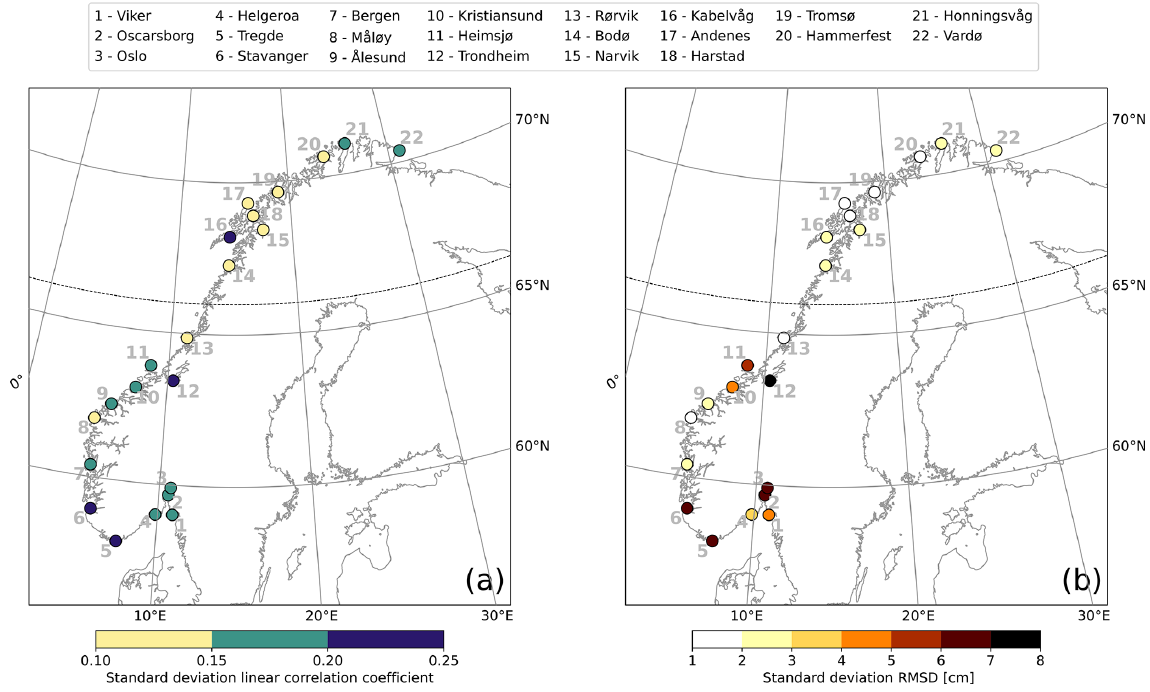
Figure 6. Comparison between coastal sea-level signals from in situ measurements and area-averaged remote sensing data. At each tide-gauge location, the standard deviation of the linear correlation coefficients (a) and of the RMSDs (b) is computed over each possible combination of the distance from the coast and of the distance from the tide gauge. The black dashed line indicates the 66 ◦ N